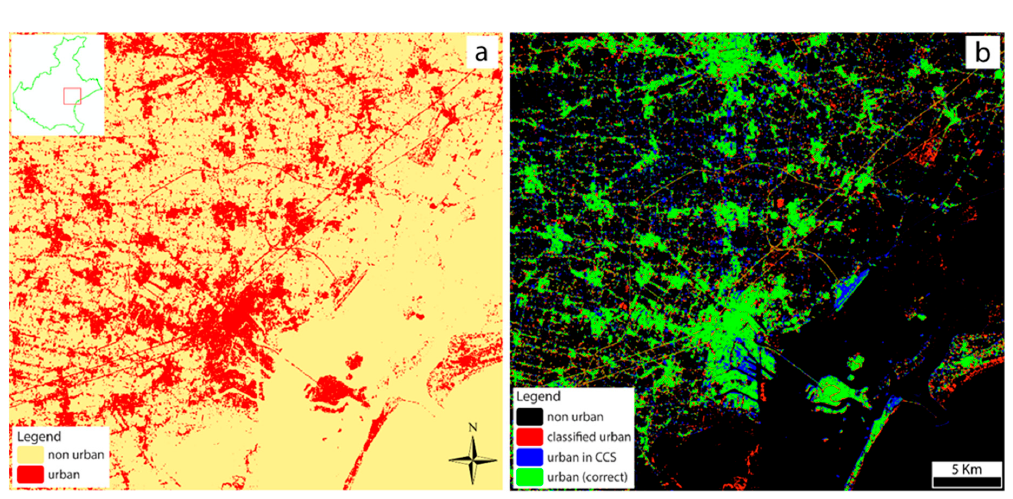
Figure 9. ( a ) Supervised classification (using ML classifier) run over a stack of interferometric coherence images produced processing a time series of Sentinel-1A images acquired from April 2019 to July 2018. ( b ) Accuracy assessments using CCS as a reference map. Table 5. Error matrix related to ML classification performed on the multitemporal coherence image in the Venice study area.